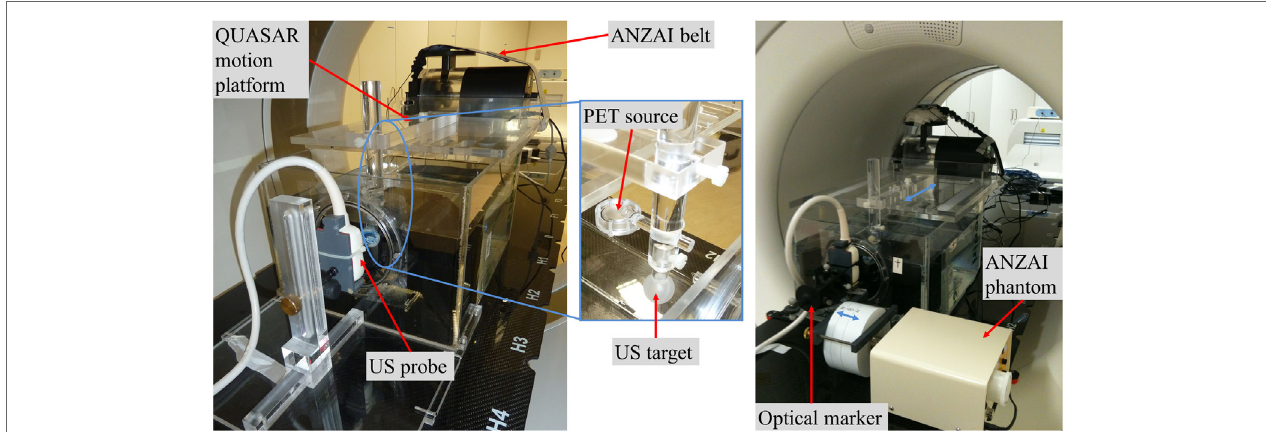
FigUre 3 | experimental setup for ultrasound-based motion tracking with static Us probe (left) and with the Us probe being moved by the anZai respiratory phantom (right) (from the optical sensor’s point of view) . The setup was positioned on the patient table of the PET/CT scanner. The US target (rubber ball) and the rigidly attached PET 22 Na point source were moved by the QUASAR motion platform. Motion was detected by the ANZAI breathing belt and the US probe in